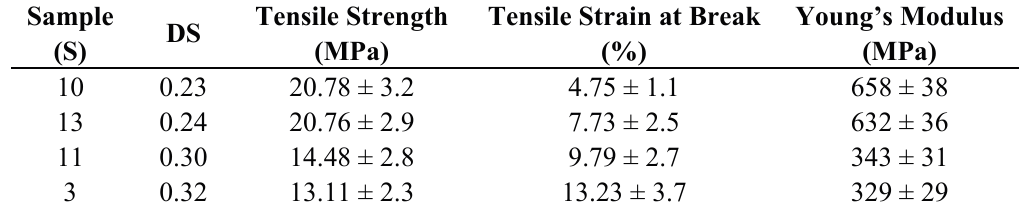
Table 2. Mechanical properties of the films produced from xylan- g -PPC copolymers.